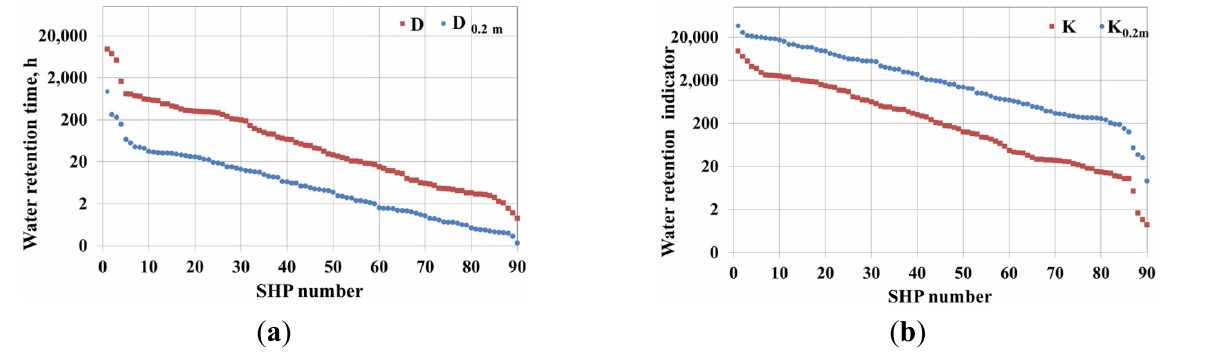
Figure 7. Water retention indicators of SHP reservoirs. D ( a ) and K ( b ) determined for the reservoir useful and power storage. The subscript 0.2 m indicates a drawdown height of 0.2 m in